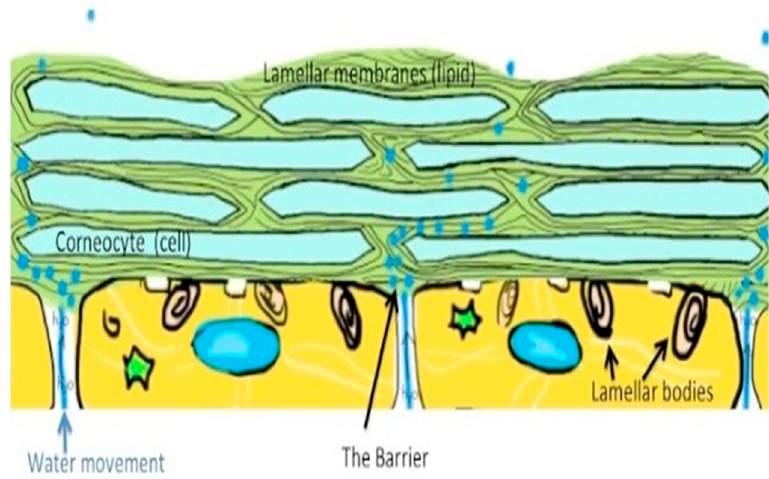
Figure 4. The so-called skin mortar and brick: lipids are the mortar and corneocytes are the bricks [13].